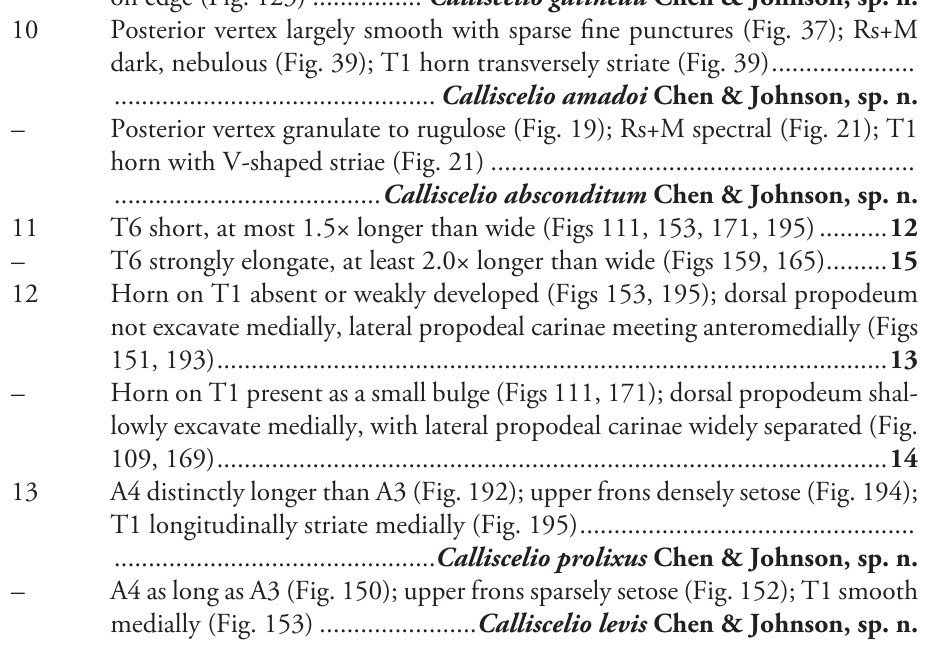
(Fig. 181); posterior vertex smooth throughout (Fig. 181) .............................. – Metascutellum with a longitudinal median carina (Fig. 115); foveolae of sc- utoscutellar sulcus between notauli as large as those along margin of axilla (Fig. 115); posterior vertex smooth to coriaceous (Fig. 115) ......................... T6 strongly elongate, at least 2.0× longer than wide (Figs 63, 93) ............... 7 – T6 short, at most 1.5× longer than wide (Figs 21, 39, 123, 224) ................ 8 7 Setae on frons short (Fig. 74); posterior vertex granulate to rugulose or densely punctate (Fig. 73); mesoscutum largely coriaceous with dense and fine punctures at posterior extreme (Fig. 73) ........ Calliscelio brevitas Chen & Johnson, sp. n. – Setae on frons long (Fig. 92); posterior vertex largely smooth with sparse fine punctures (Fig. 91); mesoscutum with anterior margin rugulose, remainder smooth (Fig. 91) ......................... Calliscelio crena Chen & Johnson, sp. n. R1 as long as r-rs (Figs 13, 212); IOS slightly less than or greater than EH (Figs 122, 218) ........................................................................................... 9 – R1 as long as 2.0× length of r-rs (Figs 21, 39); IOS distinctly less than EH (Figs 20, 38) ............................................................................................. 10 9 Mesepisternum below mesopleural depression densely punctate (Fig. 211); horn on T1 large and distinct, granulate or rugose dorsally (Fig. 217) .......... – Mesepisternum below mesopleural depression smooth (Fig. 119); horn on T1 present as a small bulge, dorsally granulate medially, with V-shaped keels on edge (Fig. 123) ................ Calliscelio gatineau Chen & Johnson, sp. n. 10 Posterior vertex largely smooth with sparse fine punctures (Fig. 37); Rs+M dark, nebulous (Fig. 39); T1 horn transversely striate (Fig. 39) ..................... – Posterior vertex granulate to rugulose (Fig. 19); Rs+M spectral (Fig. 21); T1 horn with V-shaped striae (Fig. 21) .............................................................. T6 short, at most 1.5× longer than wide (Figs 111, 153, 171, 195) .......... 12 – T6 strongly elongate, at least 2.0× longer than wide (Figs 159, 165) ......... 15 12 Horn on T1 absent or weakly developed (Figs 153, 195); dorsal propodeum not excavate medially, lateral propodeal carinae meeting anteromedially (Figs – lowly excavate medially, with lateral propodeal carinae widely separated